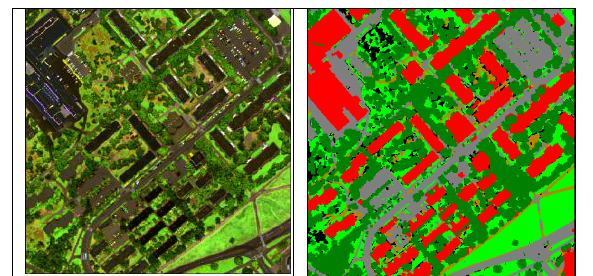
Figure 5. Optech Titan colour coded image (left) and classified image (right).